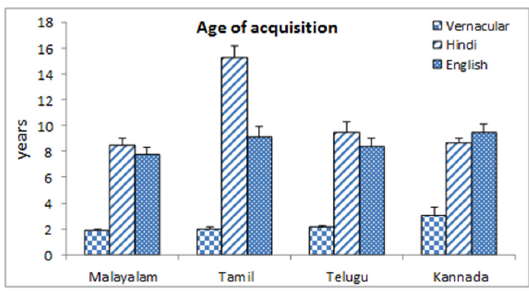
Figure-1: Starting years of language acquisition